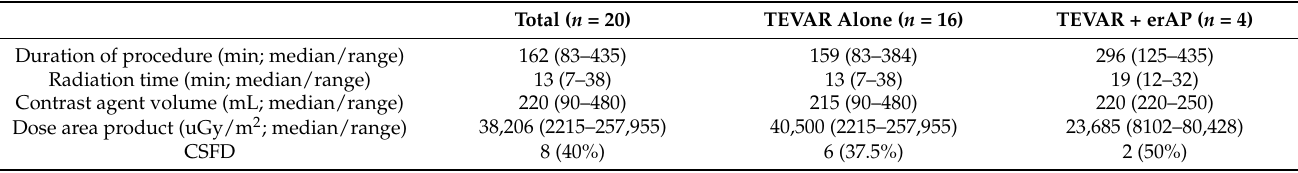
Table 2. Procedural